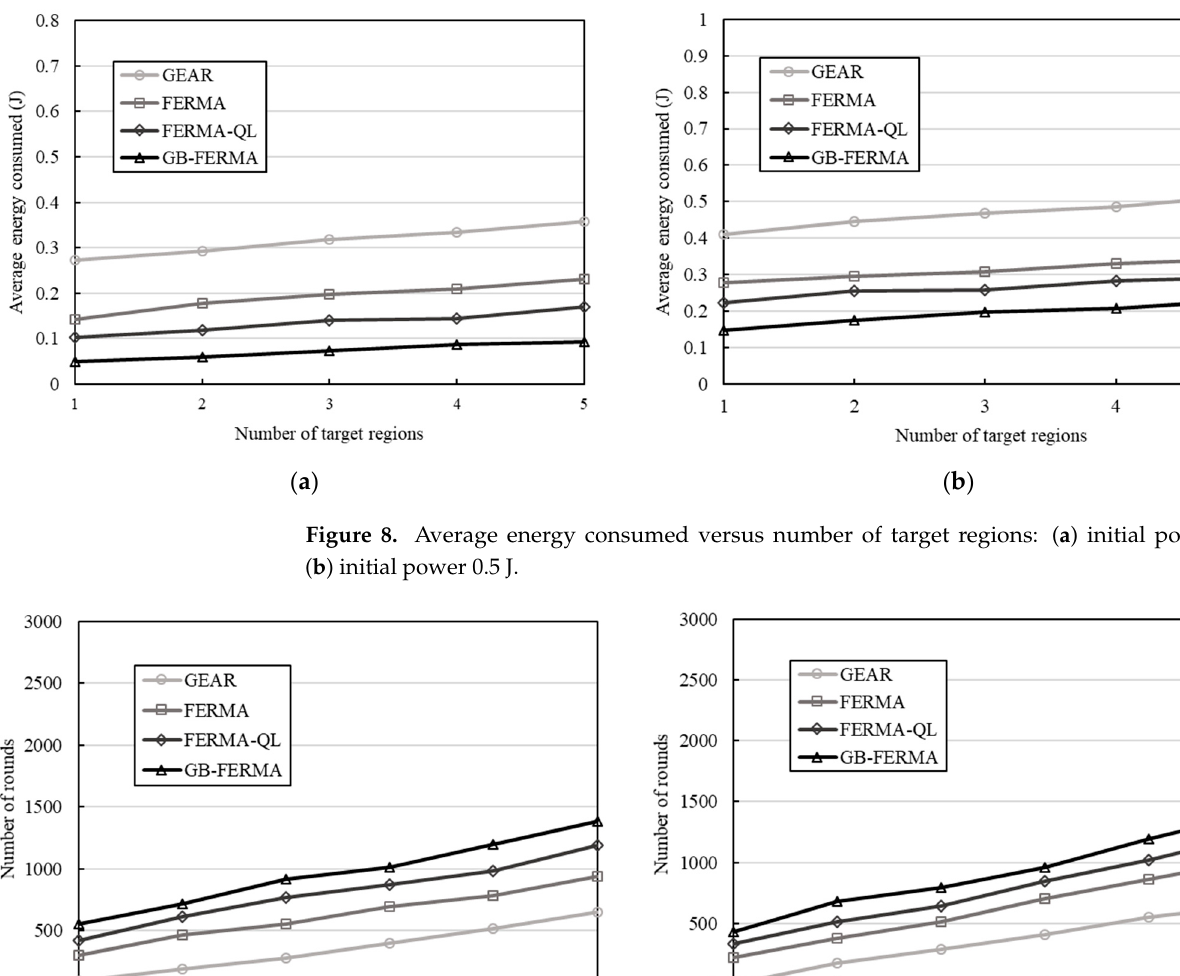
( b ) Figure 10. Number of alive nodes versus number of rounds: ( a ) initial power 0.25 J; ( b ) initial power 0.5 J.